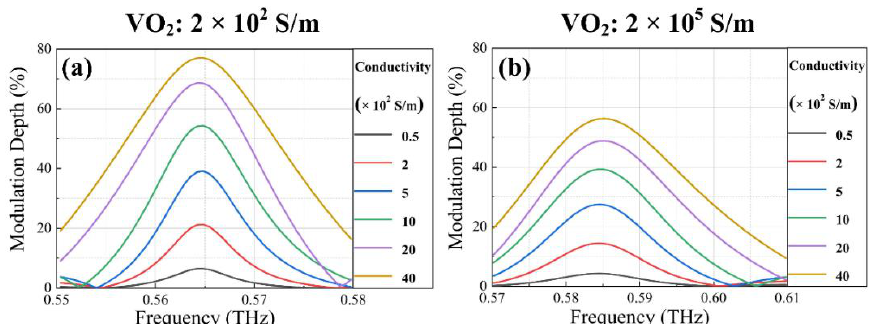
Figure 6. MD for varying Ge conductivity without and with the electrical voltage excitation. ( a ) MD depending on the conductivity of Ge layers at 0.55 – 0.58 THz when the conductivity of VO 2 bridges is 2 × 10 2 S/m. ( b ) MD depending on the conductivity of Ge layers at 0.57 – 0.61 THz when the conductivity of VO 2 bridges is 2 × 10 5 S/m.